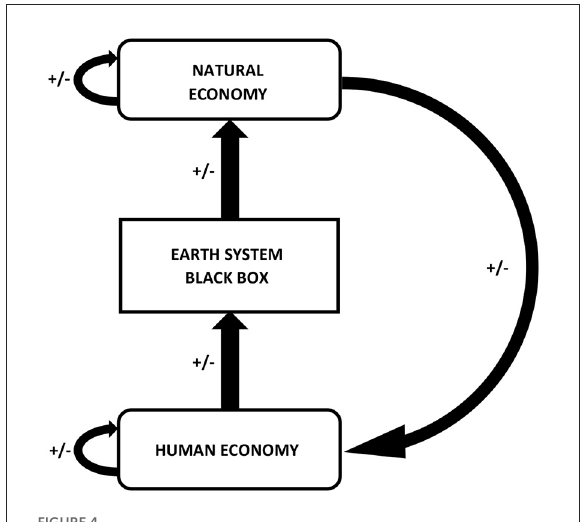
FIGURE4 The circular relationship between the Earth system, the natural economy and the human economy. The Earth system black box output feeds into the natural economy, which in turn impacts either positively or negatively upon the human economy. Both economies may grow or contract depending on the overall dynamics and the thermodynamic outputs of the system and its components. In extreme cases, a complete reset may